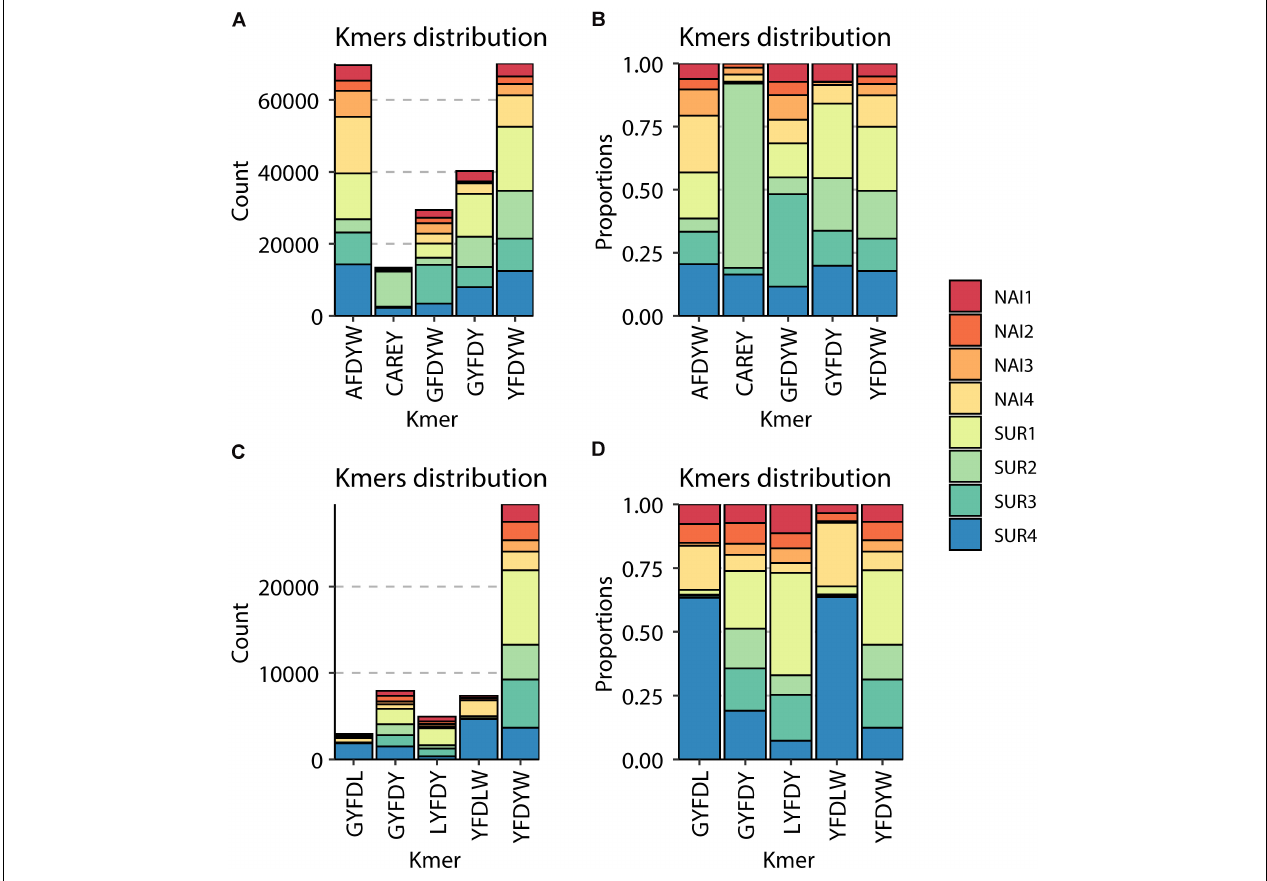
FIGURE 7 | Graphical representation of the most abundant amino acid 5-mers in the CDR3 sequences of IgM (A,B) and IgT (C,D) . For each of the naïve (NAI, n = 4) and parasite resistant (SUR, n = 4) fish. The total count (A,C) and the relative proportion in the eight samples (B,D) of each of the most abundant 5-mers are